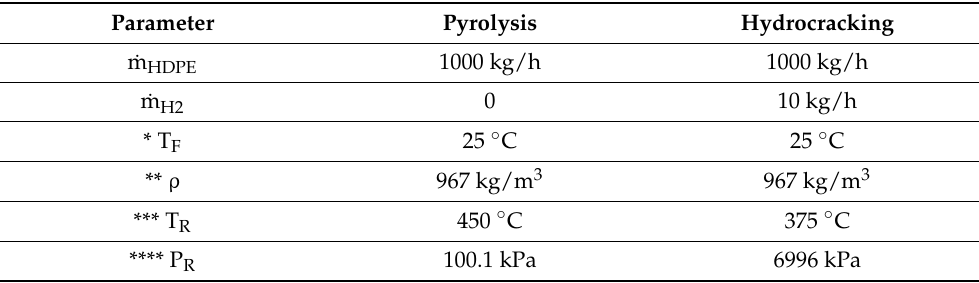
Table 10. Feedstock conditions for the pyrolysis and hydrocracking processes. Parameter Pyrolysis Hydrocracking ˙m HDPE 1000 kg/h 1000